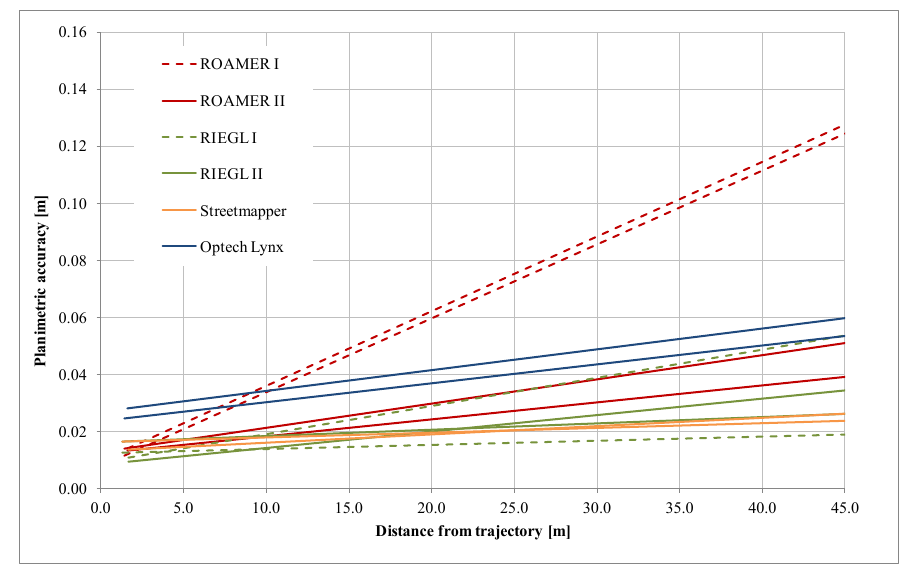
Figure 18. Planimetric accuracy as a function of distance from the trajectory; with the linear trend lines fitted to the observed errors in the two driving